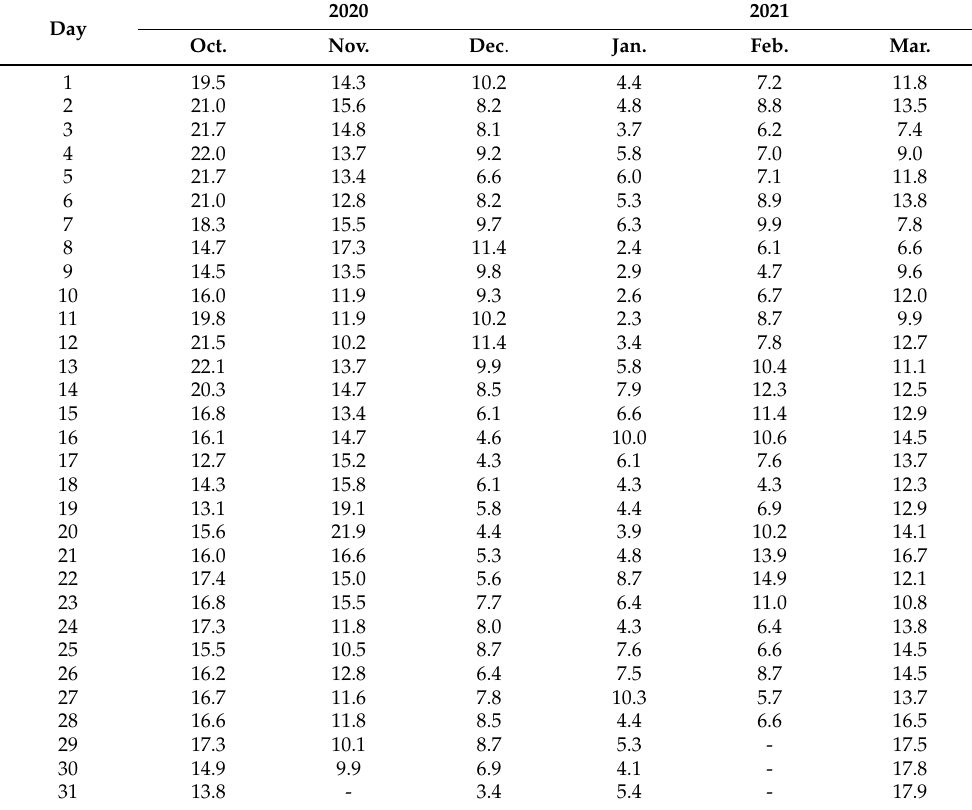
Table 3. Daily mean of outdoor temperature for Tokyo,